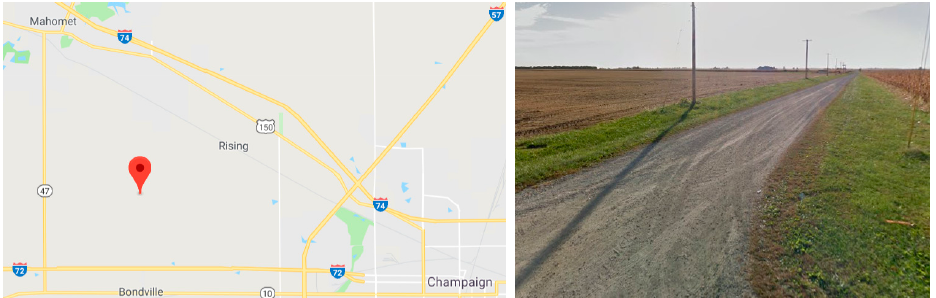
Figure 12. Ambient vibration test on country road.